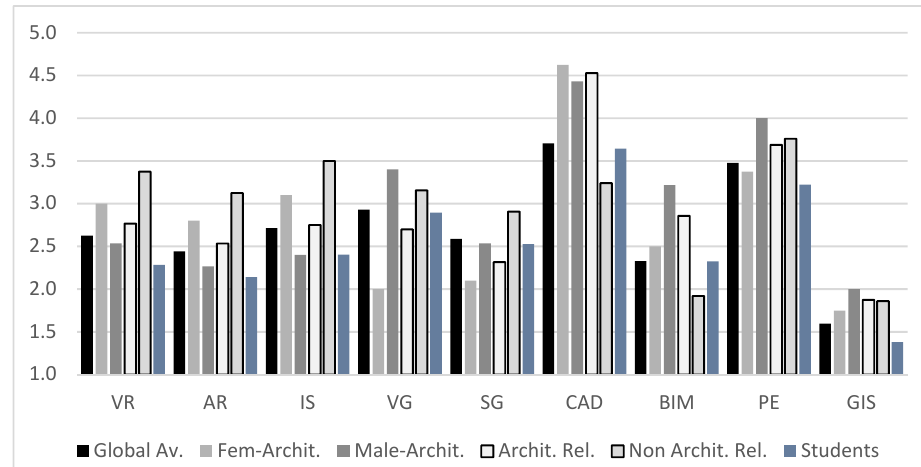
Figure 11. User experience with the technologies cited.